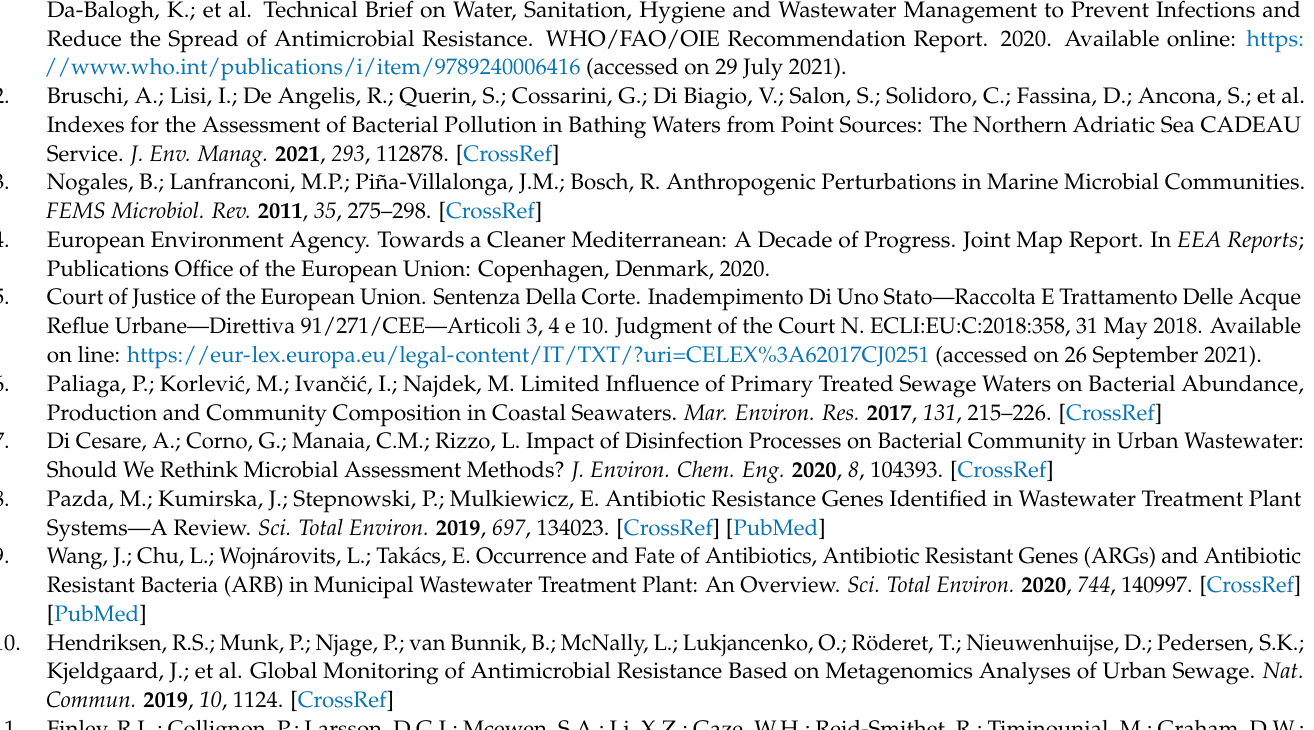
Table S2: Primer sets, Table S3: qPCR assays